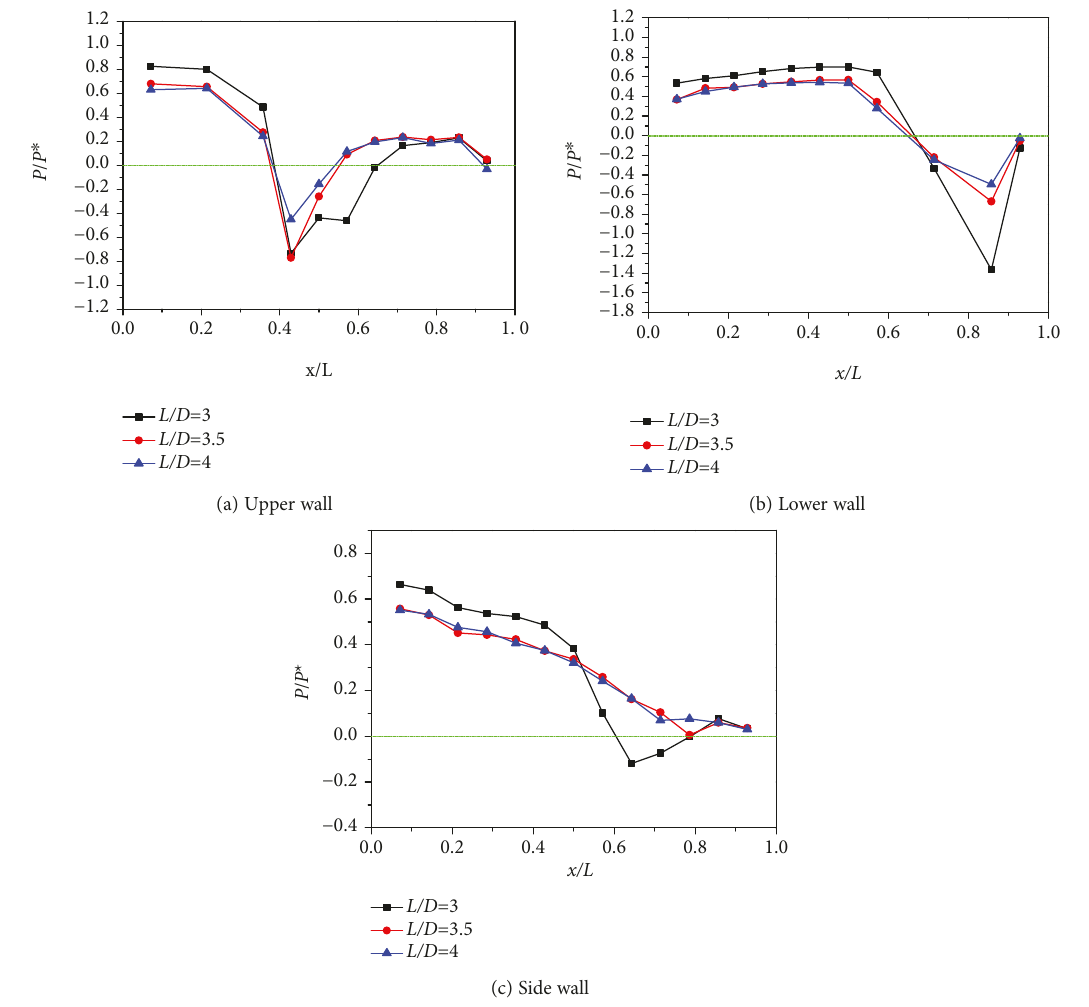
Figure 10: E ff ects of ratios of length to diameter on wall